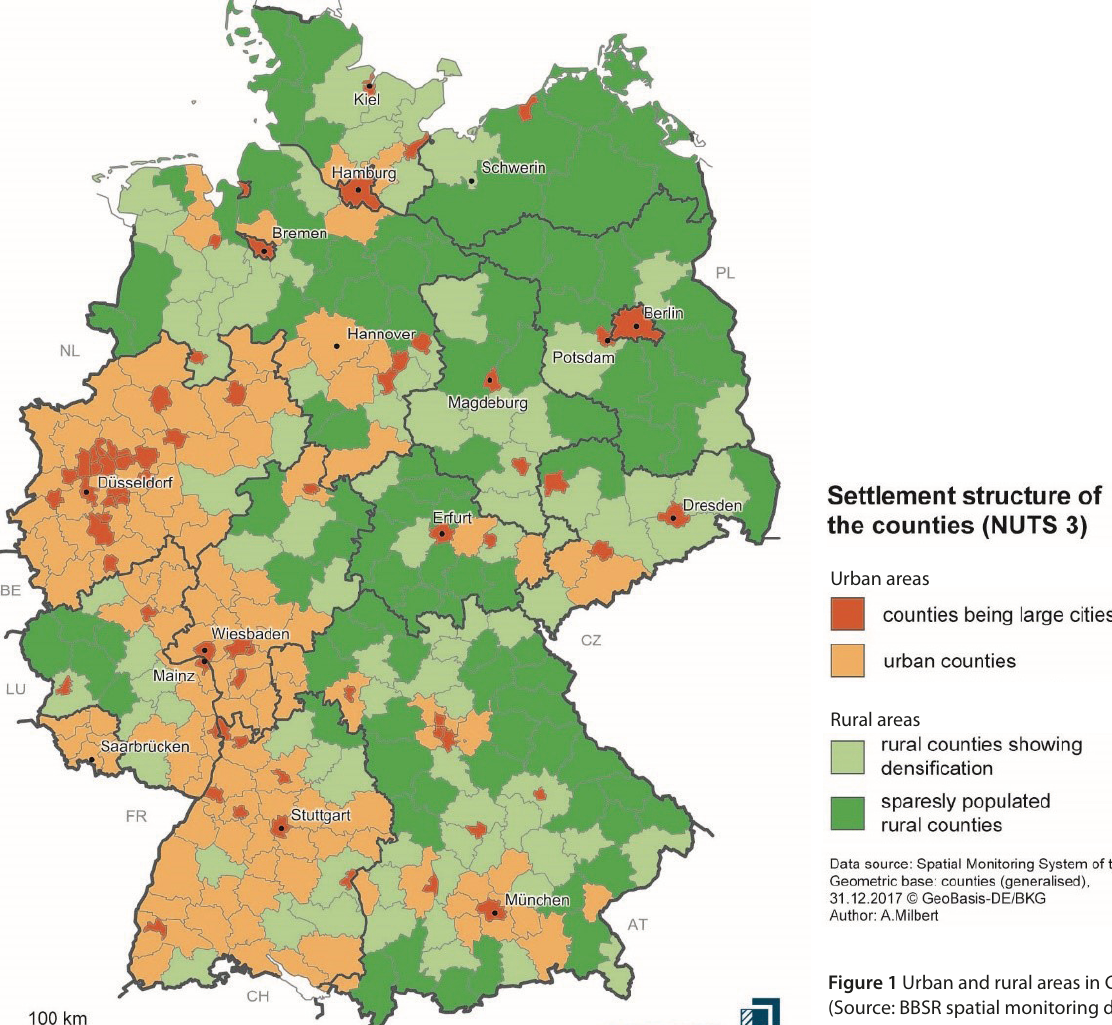
Figure 1 Urban and rural areas in Germany (Source: BBSR spatial monitoring data from